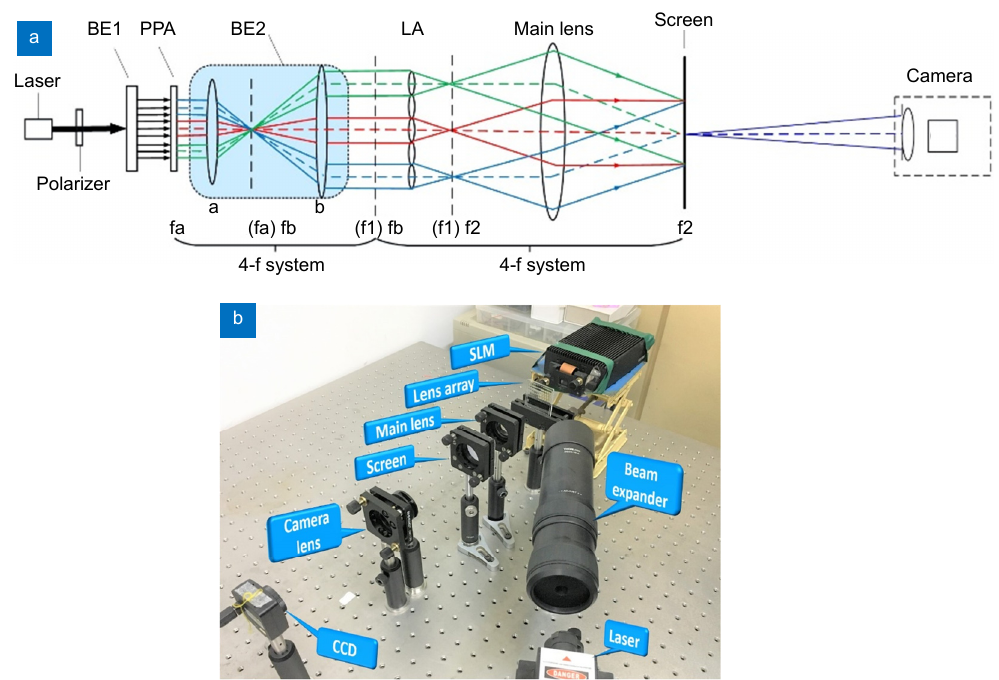
Fig. 2 | ( a ) The sketch diagram of our optical system: the PPA, LA, main lens and screen constitute a 4-f system. For a higher-order PPA, another beam expander (BE2) is added. Incoherent speckle patterns will superpose on the screen under the action of LA and main lens. ( b ) The experi- mental setup of the proposed system.